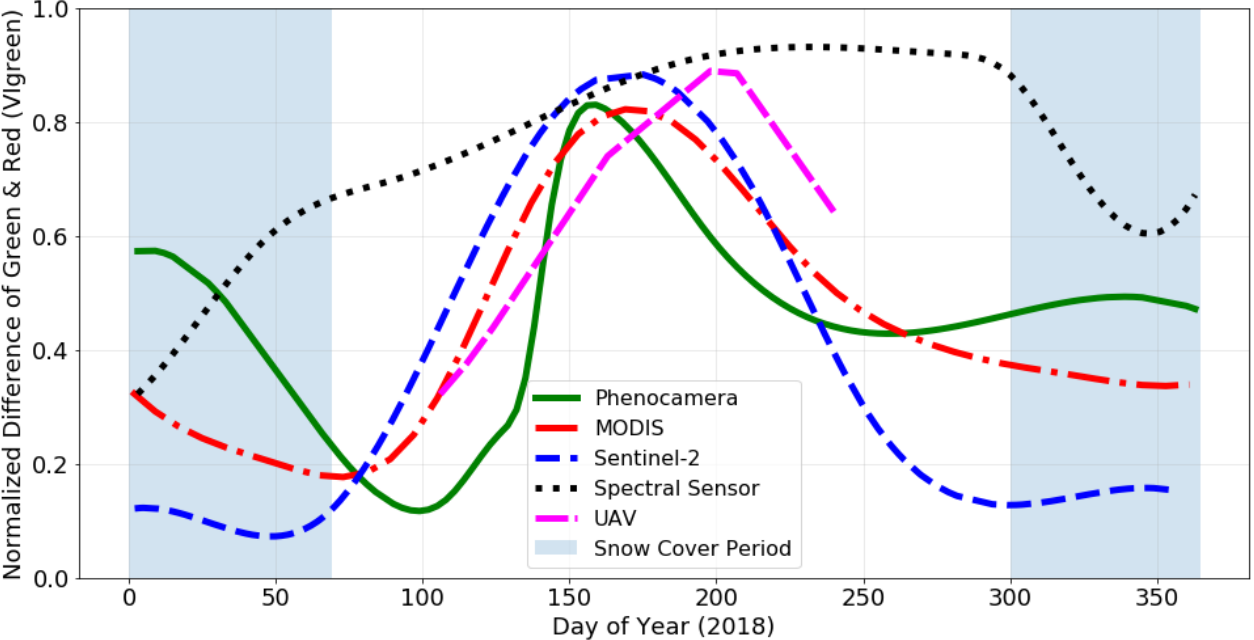
Figure 12. VIgreen values are presented to compare seasonal trends of greenness derived from PhenoCam VIgreen (green), MODIS VIgreen (red), Sentinel-2 VIgreen (blue), SRS VIgreen (black), and UAV VIgreen (magenta) sensors. The y axis is a normalized scale from indices’ minimum to maximum values (to make it easy for effective visualization and comparison with other VI profiles).